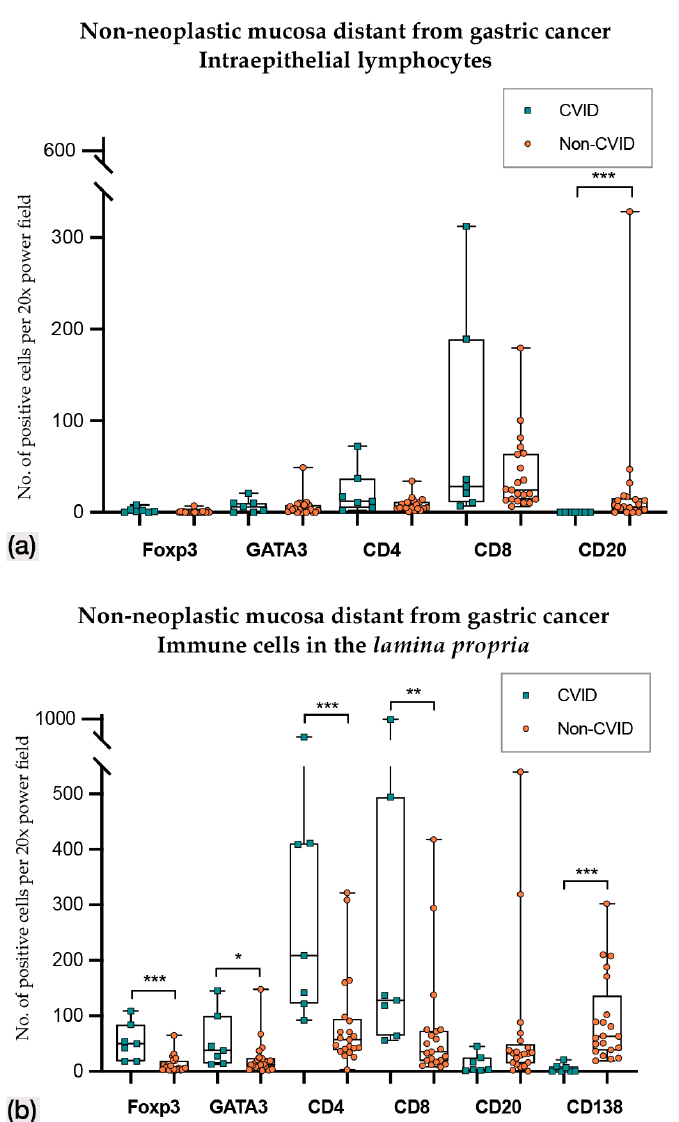
Figure 5. ( a ) Intraepithelial lymphocyte counts in non-neoplastic mucosa adjacent to gastric cancer from CVID and non-CVID patients; ( b ) counts of immune cells in the lamina propria in non-neoplastic mucosa adjacent to gastric cancer from CVID and non-CVID patients. Statistically significant results are highlighted by asterisks: * p ≤ 0.05; ** p ≤ 0.01; *** p ≤